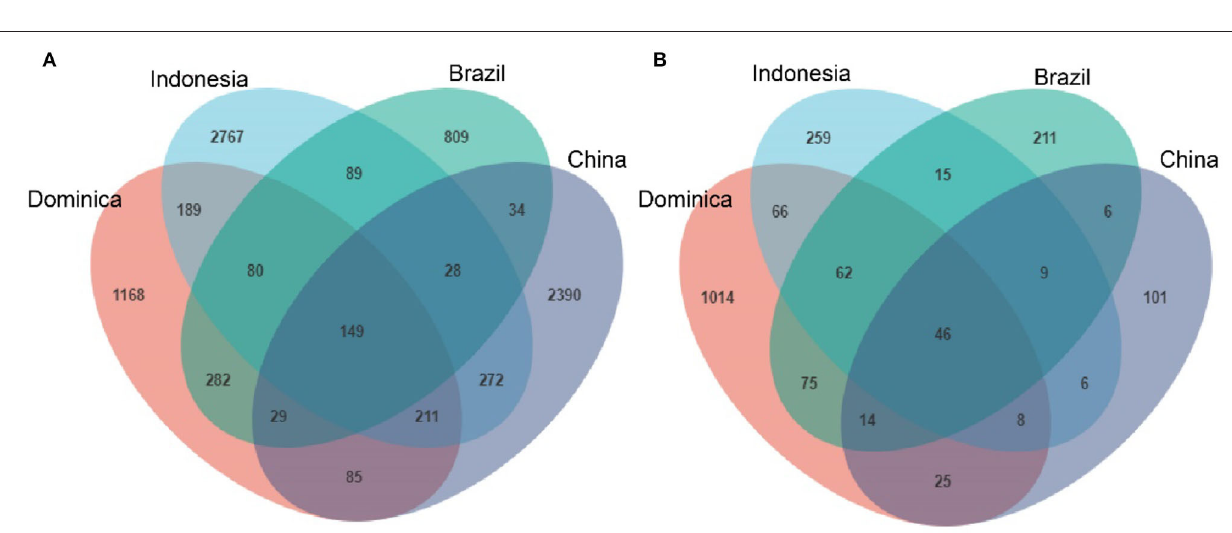
Frontiers in Microbiology |